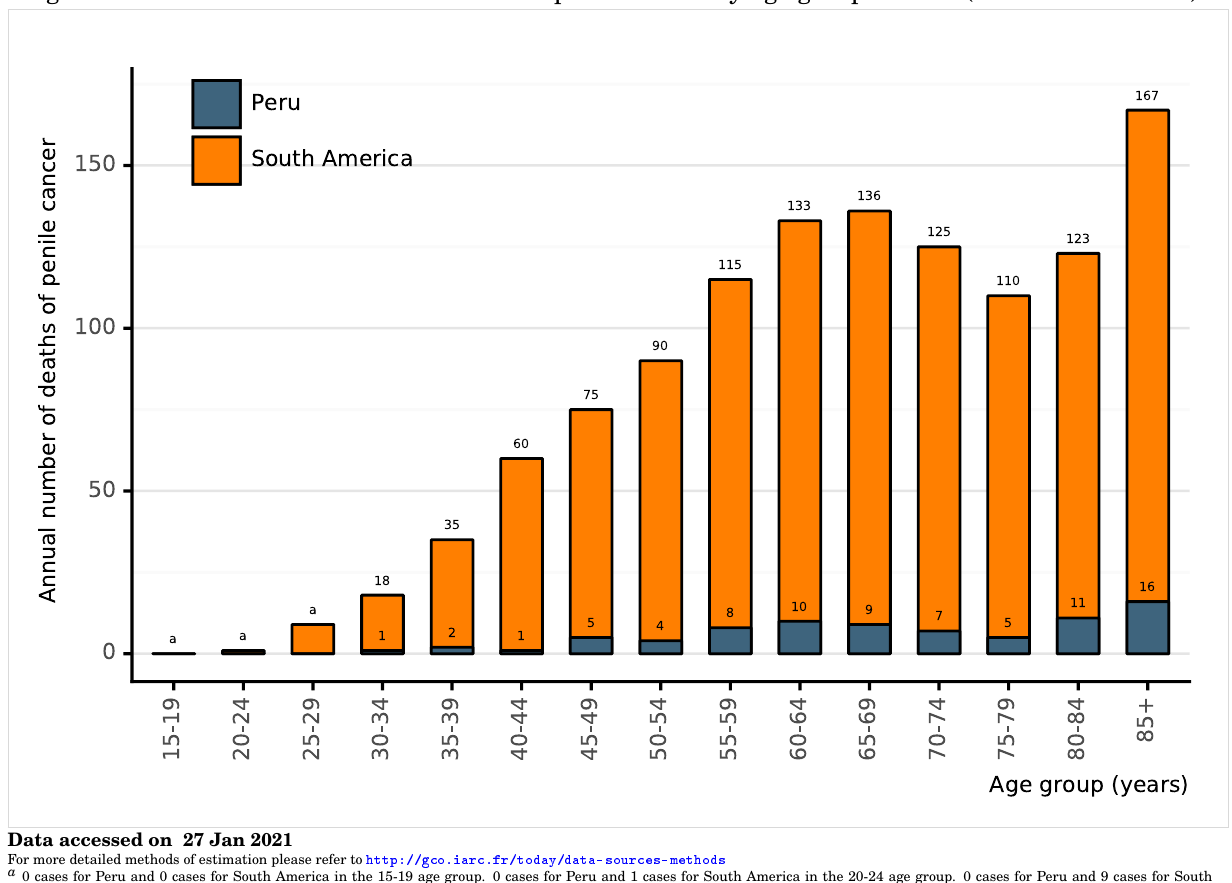
Figure 120: Annual number of new deaths of penile cancer by age group in Peru (estimates for